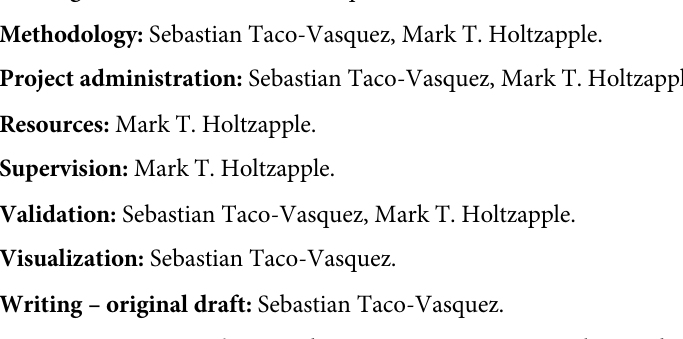
S5 Table. Compound distribution for the acetone reaction over